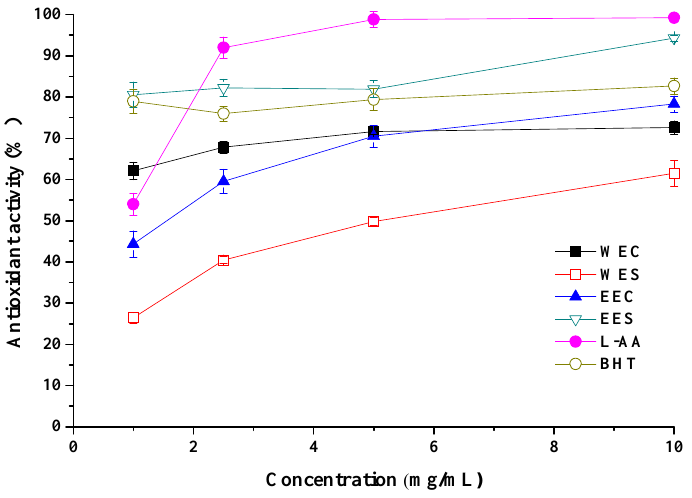
Figure 1. Antioxidant activity of ethanolic and hot water extracts from stipe and cap of Coprinus comatus